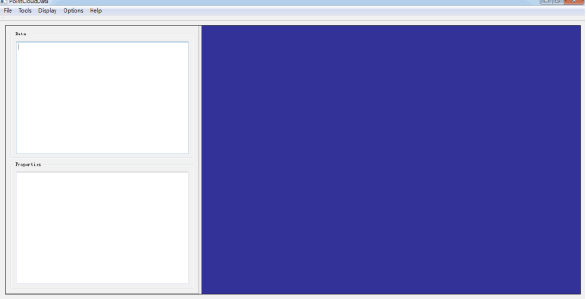
Figure 5. Main interface of data visualization